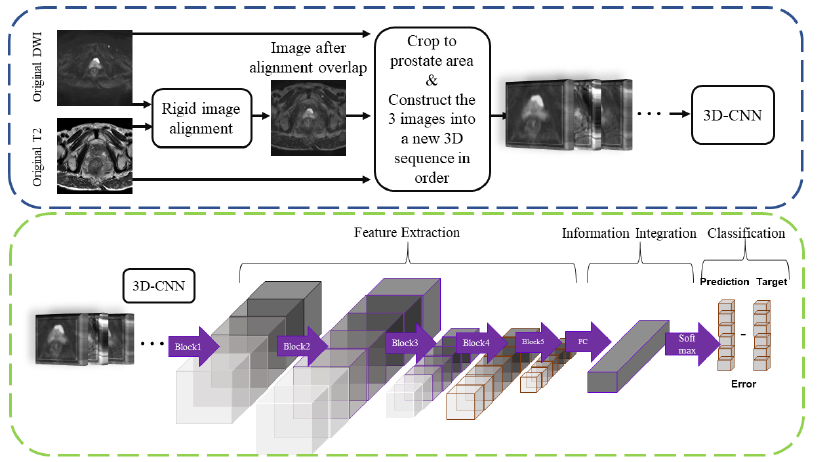
Figure 1. The framework of the proposed method consists of four key steps: (1) rigid multiparameter (DWI, T2) image alignment, (2) prostate region cropping, and (3) building a new 3D image sequence for input into a 3D-CNN.